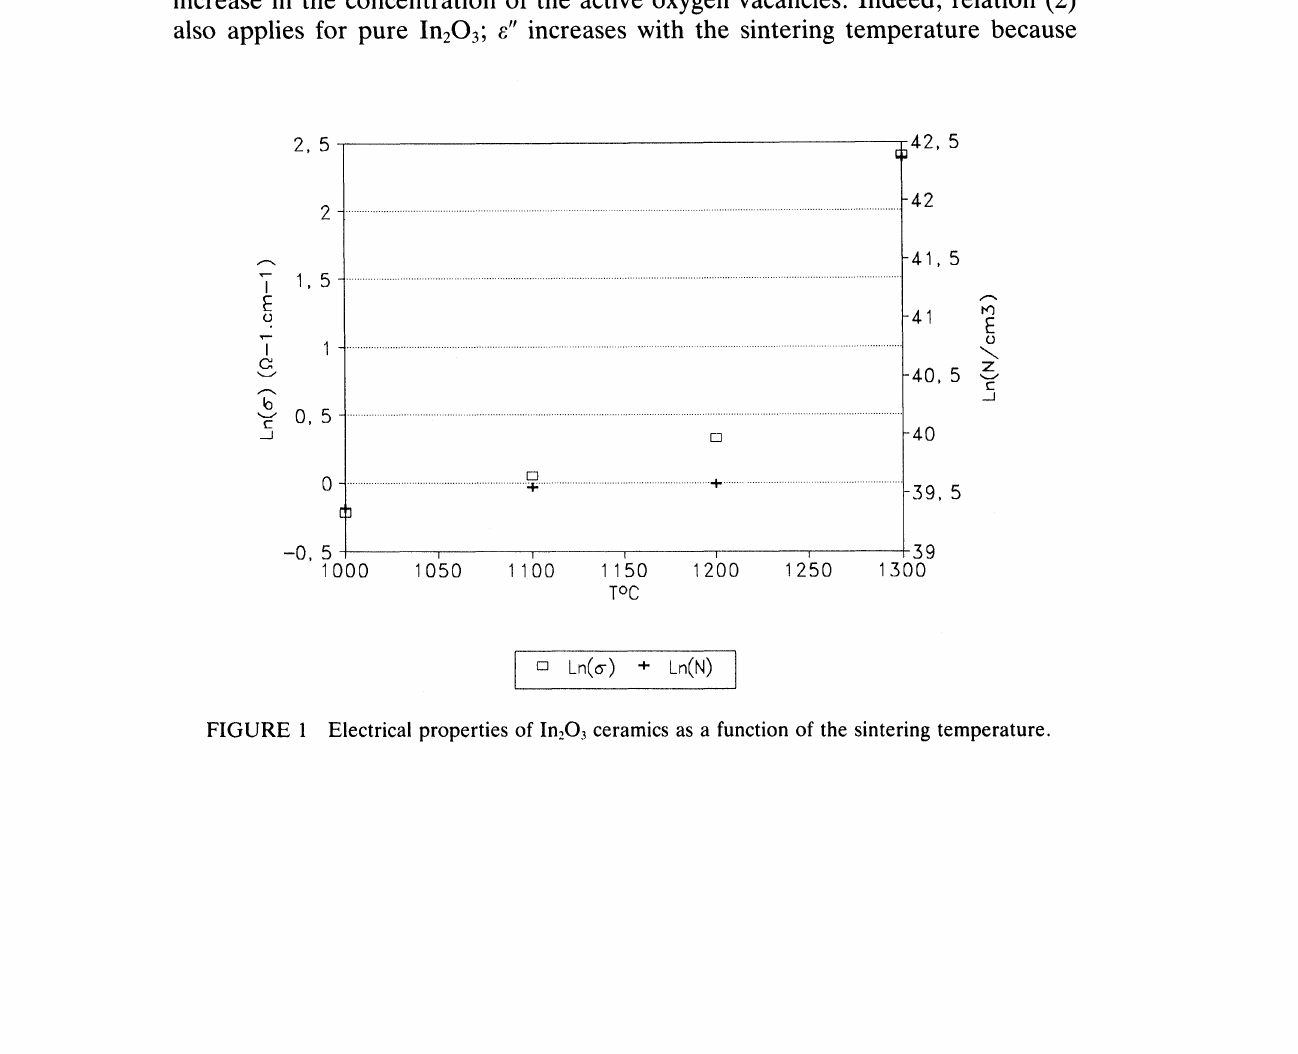
FIGURE Electrical properties of In:O3 ceramics as a function of the sintering